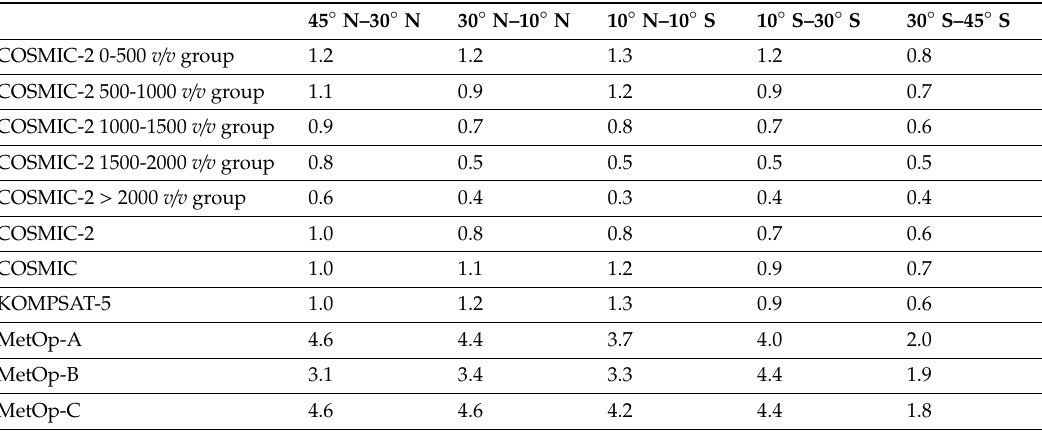
Table 1. The corresponding penetration heights for 80% of accumulated samples collected from June to October 2019 at the 45 ◦ N–30 ◦ N and 30 ◦ N–10 ◦ N, 10 ◦ N–10 ◦ S, 10 ◦ S–30 ◦ S, and 30 ◦ S–45 ◦ S latitude bands for COSMIC-2, COSMIC, KOMPSAT-5, and MetOp -A, / -B, -C GRAS. COSMIC-2 penetration depths are separated into the 0–500 v / v group, 500–1000 v / v group, 1000–1500 v / v group, 1500–2000 v / v group, and > 2000 v / v group.